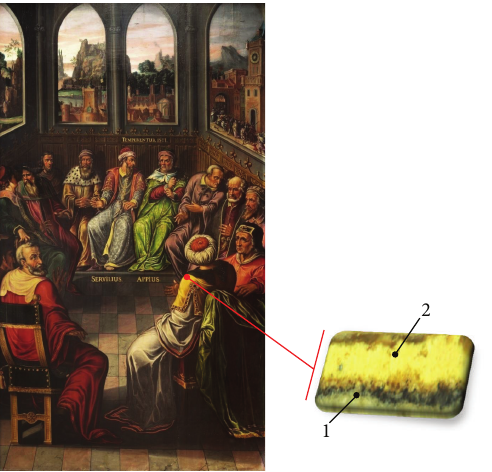
Figure 1: “Servilius Appius” (1608-1609) by Isaac van den Blocke and a cross-section of sample (SA): SA.1—white ground layer/un- derpainting and SA.2—yellow painting layer.